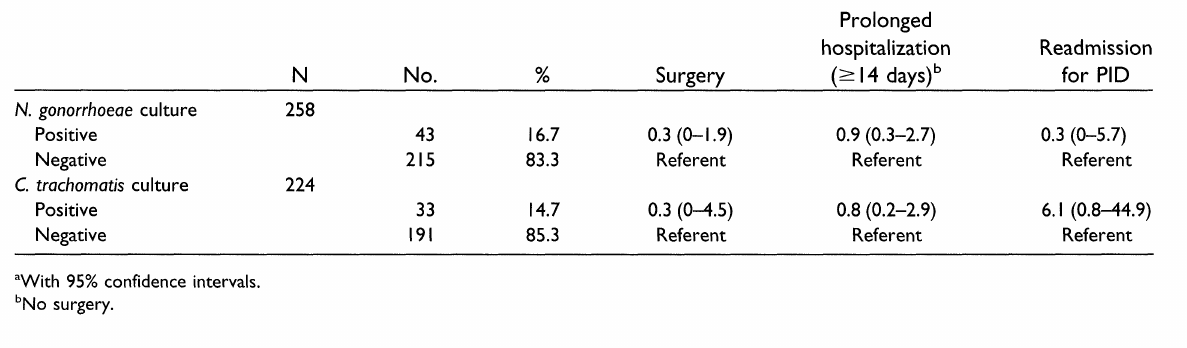
Referent Referent Referent